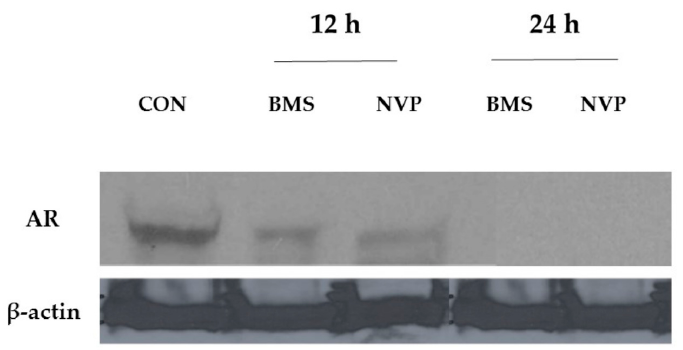
Figure 7. Effect of IGF1R/IR antagonists on AR expression in mesenchymal-subtype TNBC cell line BT549. BT549 (mesenchymal-like) cultures were exposed to control (CON), BMS-754807 (BMS; 20 μ M) or NVP-AEW807 (NVP; 8 μ M) for 12 or 24 h. Total protein was isolated, processed and transferred to PVDF membranes which were probed for AR expression (1:500, Cell Signaling #5153). β -actin (1:2000,